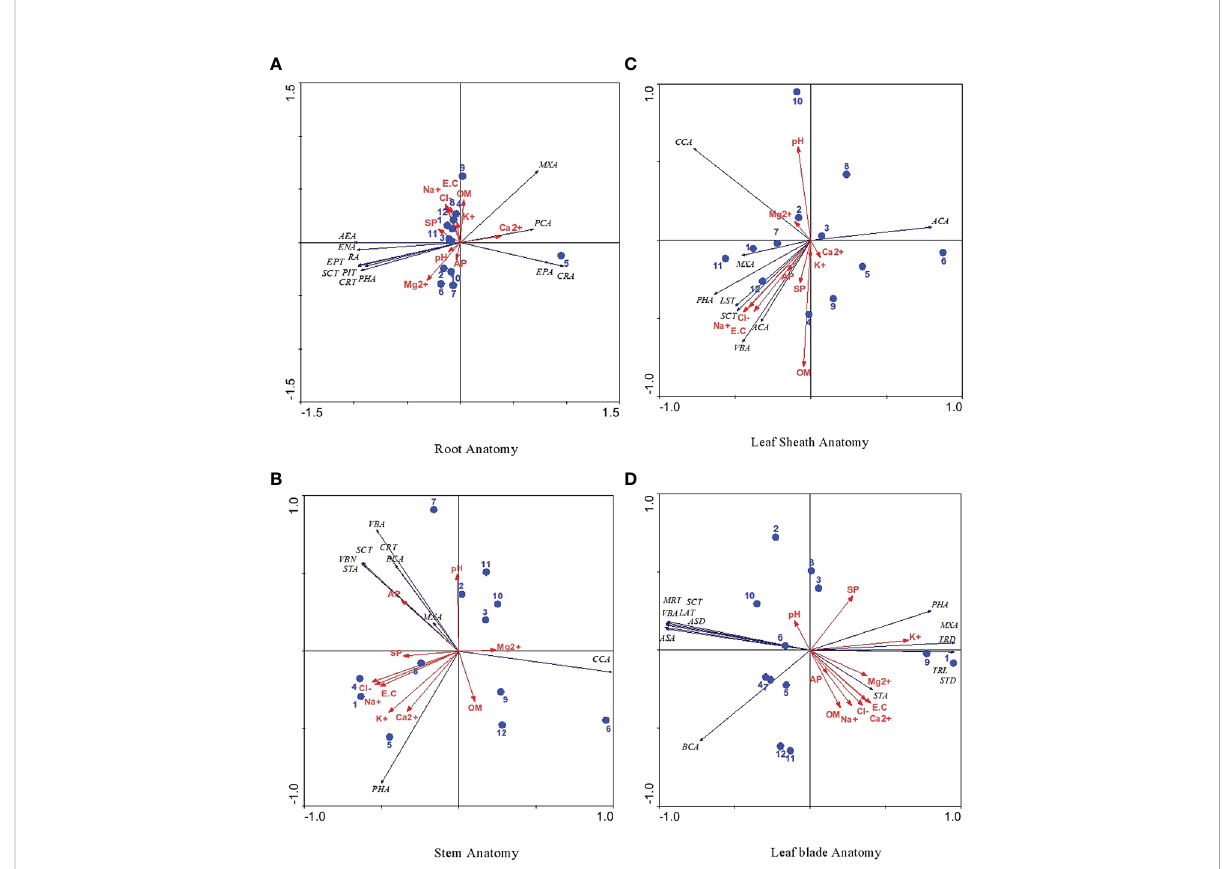
FIGURE 6 (A-D) : RDA ordination triplot showing correlation of soil physico-chemical, anatomical characteristics of cynodon dactylon ecotypes collected from the Punjab, Pakistan. 1 Derawar Fort-Saline Desert, 2 Muzaffar Garh-River Bank, 3 Khabbeki Lake-Hyper Saline, 4 Ucchali Lake- Hyper Saline, 5 Kalar Kahar Lake-Saline, 6 Treemu-Saline Wetland, 7 Sahianwala-Saline Wetland, 8 Sahianwala-Hyper Saline, 9 Pakka Anna-Hyper Saline, 10 Pakka Anna-Reclaimed Field, 11 Botanic Garden-Non Saline, 12 Gatwala-Saline Semiard, Leaf anatomical characteristics are abbreviated as LBT, Leaf Blade Thickness; SCT, Sclerenchymatous Thickness; BCA, Bulliform Cell Area; VBA, Vascular Bundle Area; MXA, Metaxylem Area; PHA, Phloem Area; TRL, Trichome Length; TRD, Trichome Density; ASA, Abaxial Stomatal Area; ASD, Abaxial Stomatal Density; ADA, Adaxial Stomata Area and ADD, Adaxial Stomatal